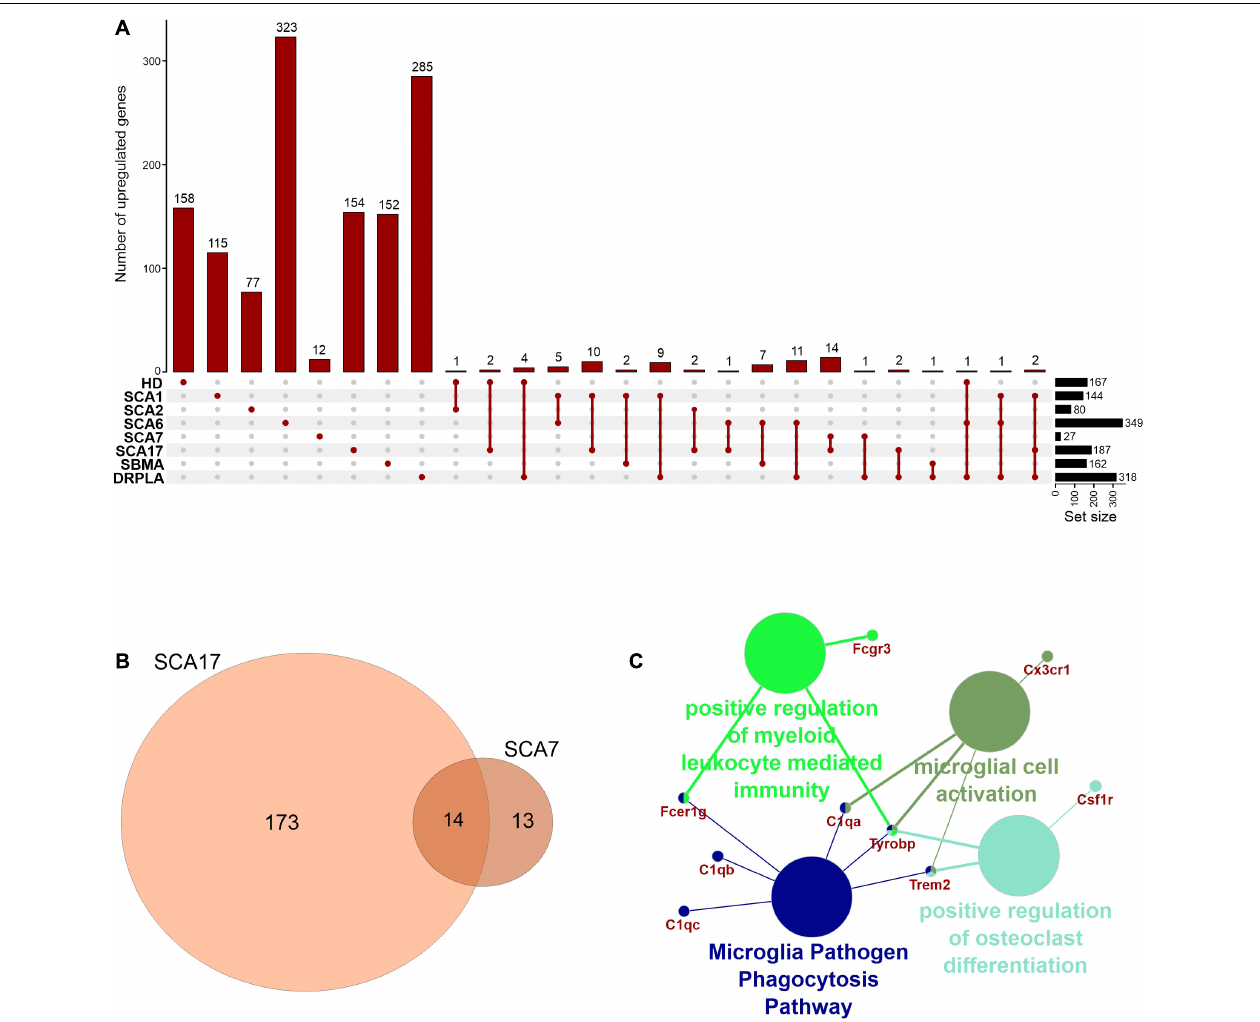
FIGURE 5 | Overlap of significantly upregulated genes from mice transcriptomic data from different PolyQ diseases. (A) UpsetR analysis was used to see the overlap between upregulated genes identified in different PolyQ diseases. (B) Venn diagrams visualizing the overlap between genes upregulated in SCA7 and SCA17. (C) ClueGO analysis of genes commonly upregulated in SCA7 and